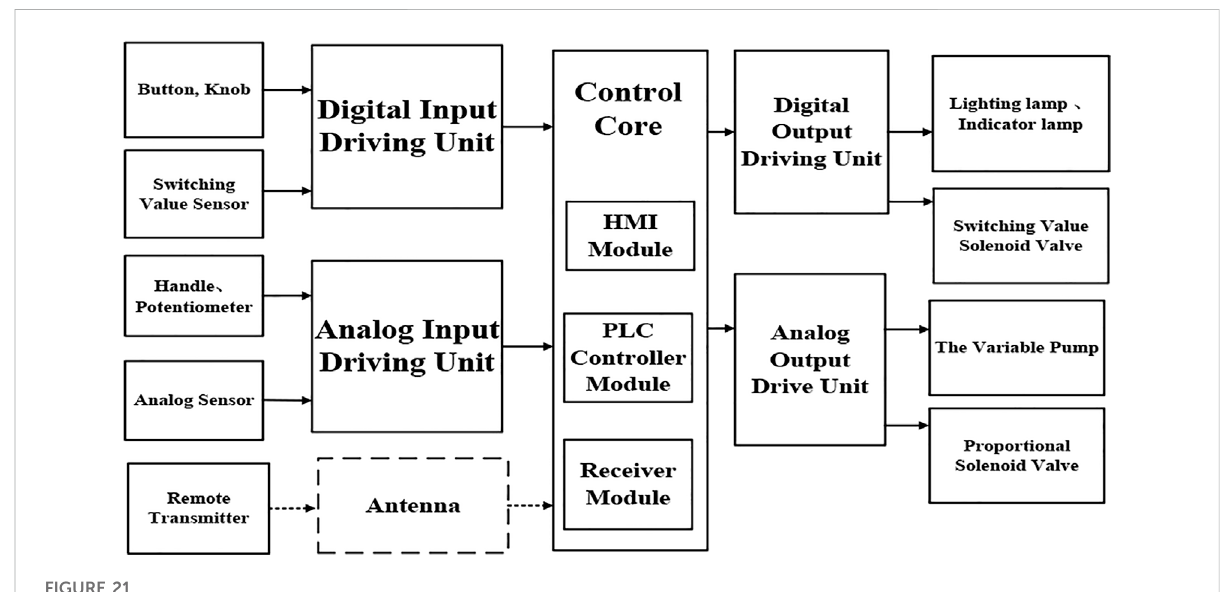
FIGURE 21 Hardware structure block diagram of the control system.